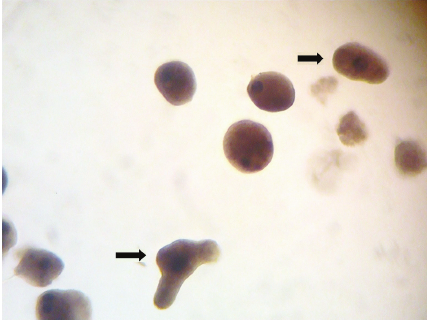
Figure 1: Cysts and trophozoites of Entamoeba histolytica (arrows); iron hematoxylin stain of fecal sample, magnification ×